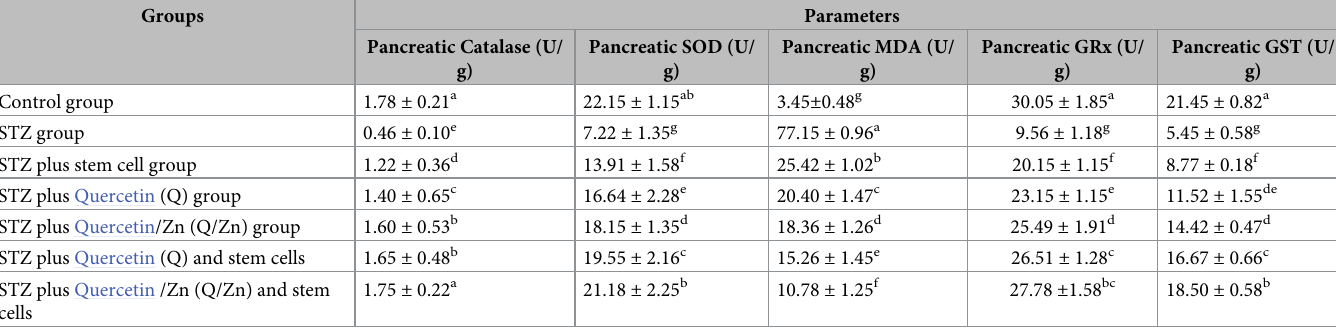
Table 5. Changes in oxidative/antioxidant parameters of antioxidant enzymes in pancreatic tissues of control and treated male rats with quercetin, quercetin/Zn, or stem cells and their combinations.